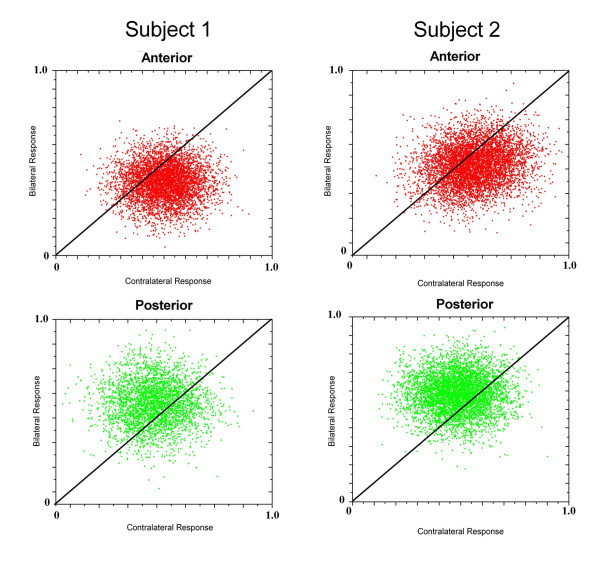
Cluster plots of contralateral vs. bilateral response of 2 subjects. For each cluster plot, values of individual pixels are plotted as a function of the absorbance measured at that pixel to the contralateral stimulus (horizontal axis) vs. the response measured at the same locus (or pixel) evoked by the bilateral stimulus (vertical axis). Reference line, plotted at a slope of 1, indicates where pixels with equal values for both conditions lie. Note that in the anterior region, the majority of the pixels are below the reference line (response to bilateral stimulus was weaker than the response to the contralateral stimulus) and that in the posterior region, the majority of the pixels are plotted above the reference line (response to bilateral stimulus is greater than the response to the contralateral stimulus). Plots are normalized (minimum absorbance value scaled to 0; maximum scaled to 1).